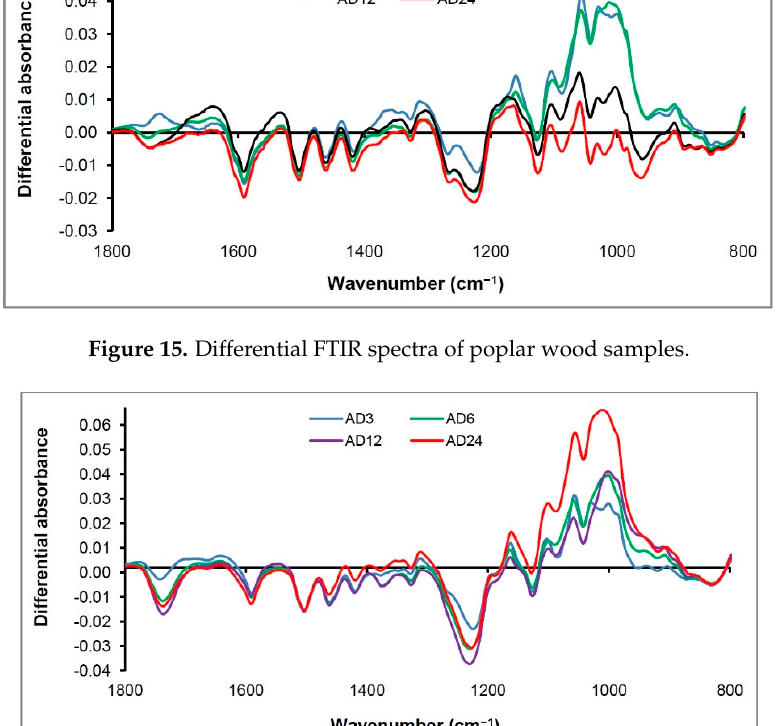
Figure 16. Differential FTIR spectra of alder wood samples.